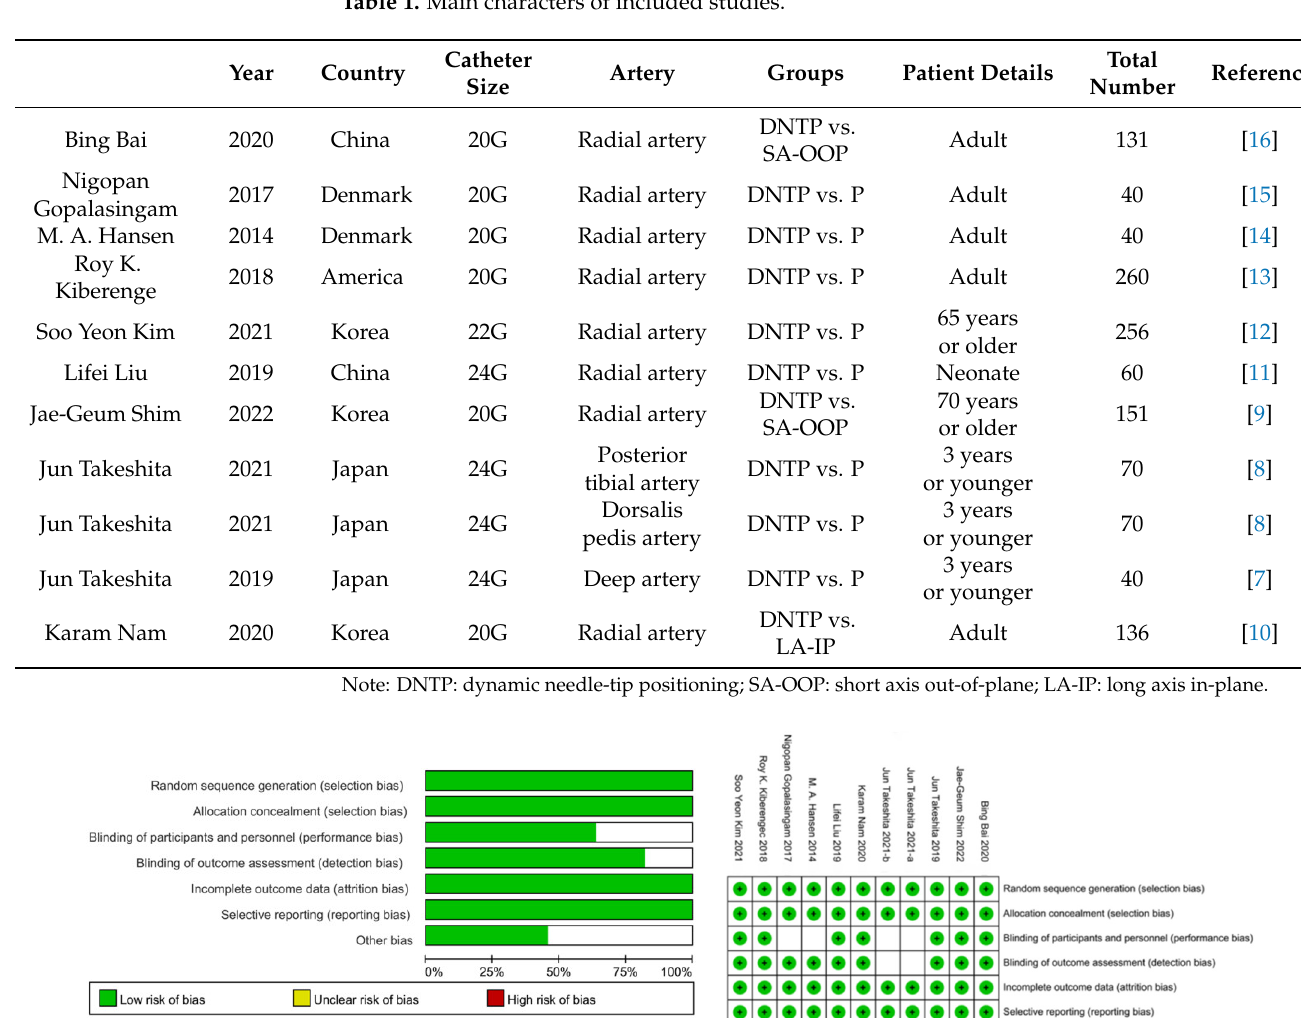
Table 1. Main characters of included studies.